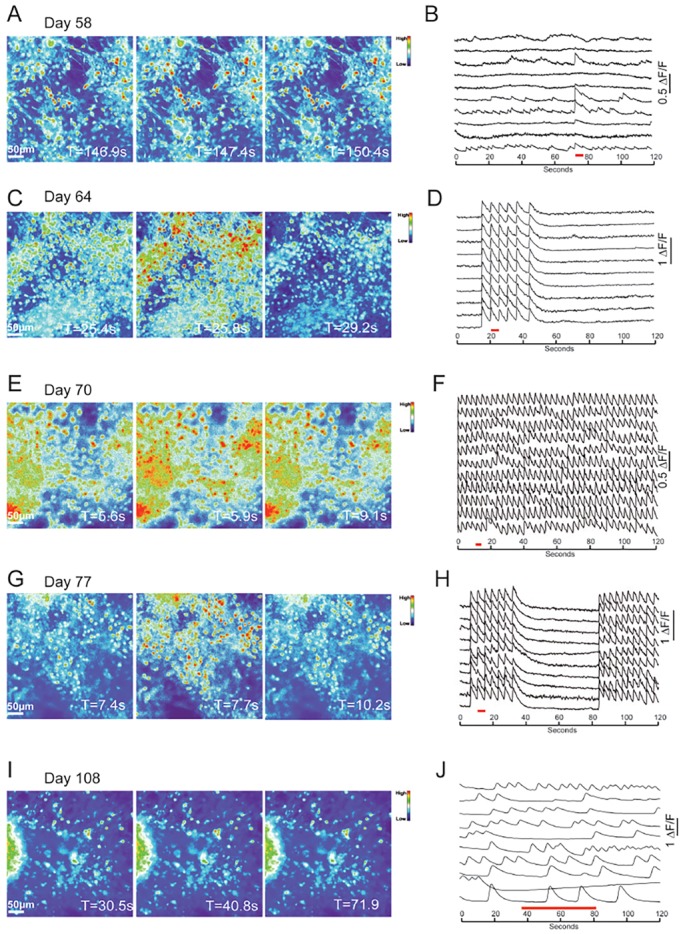
Synchronised network development in hPSC-derived cortical cultures. (A,C,E,G) Frames of calcium recordings showing synchronous firing at days 58, 64, 70 and 77, and (I) asynchronous firing on day 108 in cells loaded with OGB. (B) ΔF/F trace demonstrating that small numbers of cortical neurons in day-58 cultures fire synchronised transients. (D) By day 64, the majority of OGB-labelled cells participate in synchronised firing, and transients are more frequent. (F) The frequency of synchronised firing peaks around day 70, and (H) declines by day 77. (J) By day 108, neuronal activity is asynchronous. On each trace, the time period represented by the frames in A,C,E and G is highlighted by a red line.